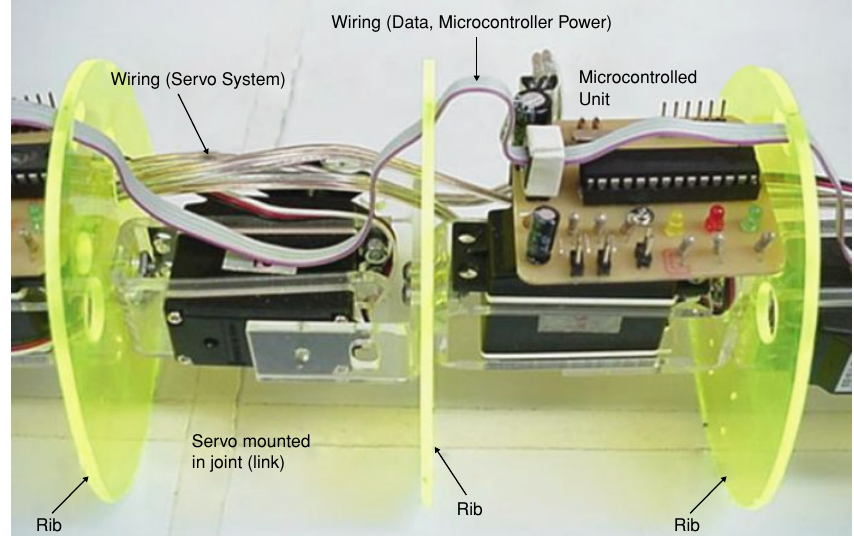
Figure 3 Lateral view of ANA II’s segment.